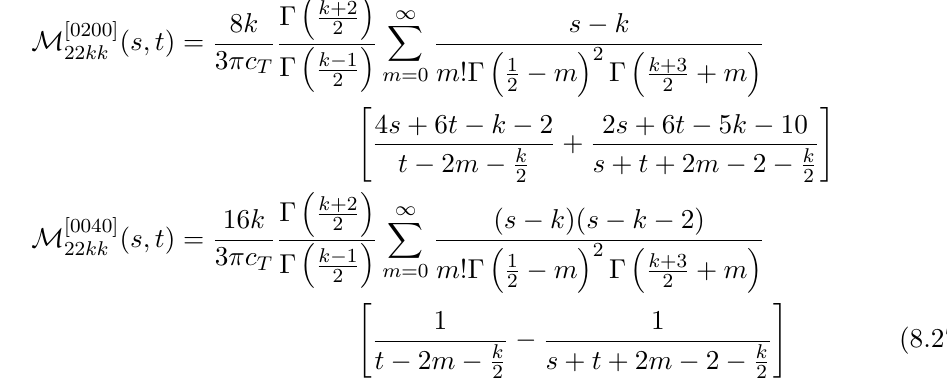
Figure 3. The complex s -plane showing the poles of Γ axis for clarity. The red contour encloses the sequence that increases from s = k − 1 avoids the sequence that decreases from s = k − 3 for (8.21). It must be deformed until it reaches the imaginary axis which is the Mellin-Barnes contour for the integral in (8.23) that involves Γ (cid:0) 1 includes residues at a discrete set of points. Note that we have suppressed the poles of other gamma functions that are irrelevant to this